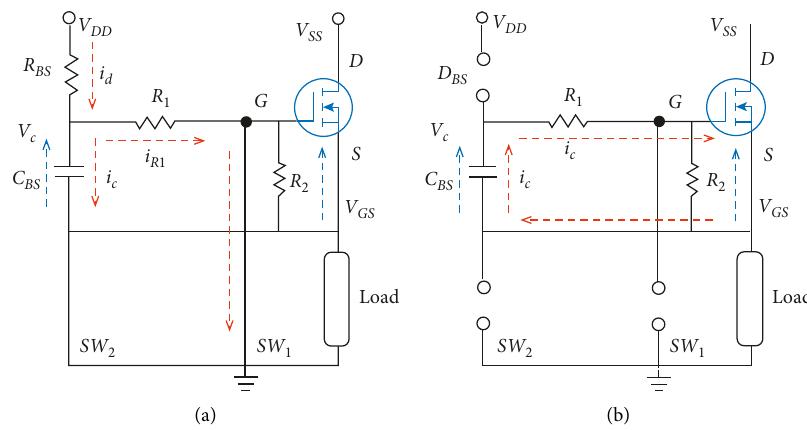
Figure 3: The charging and discharging modes of the bootstrap capacitor.